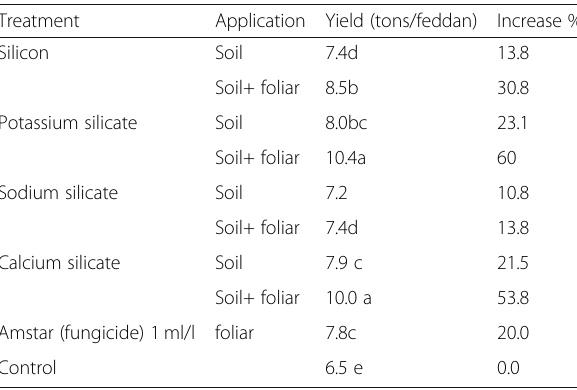
Table 3 Effect of silicon and potassium, sodium and calcium silicates, and a fungicide on strawberry yield under field conditions Treatment